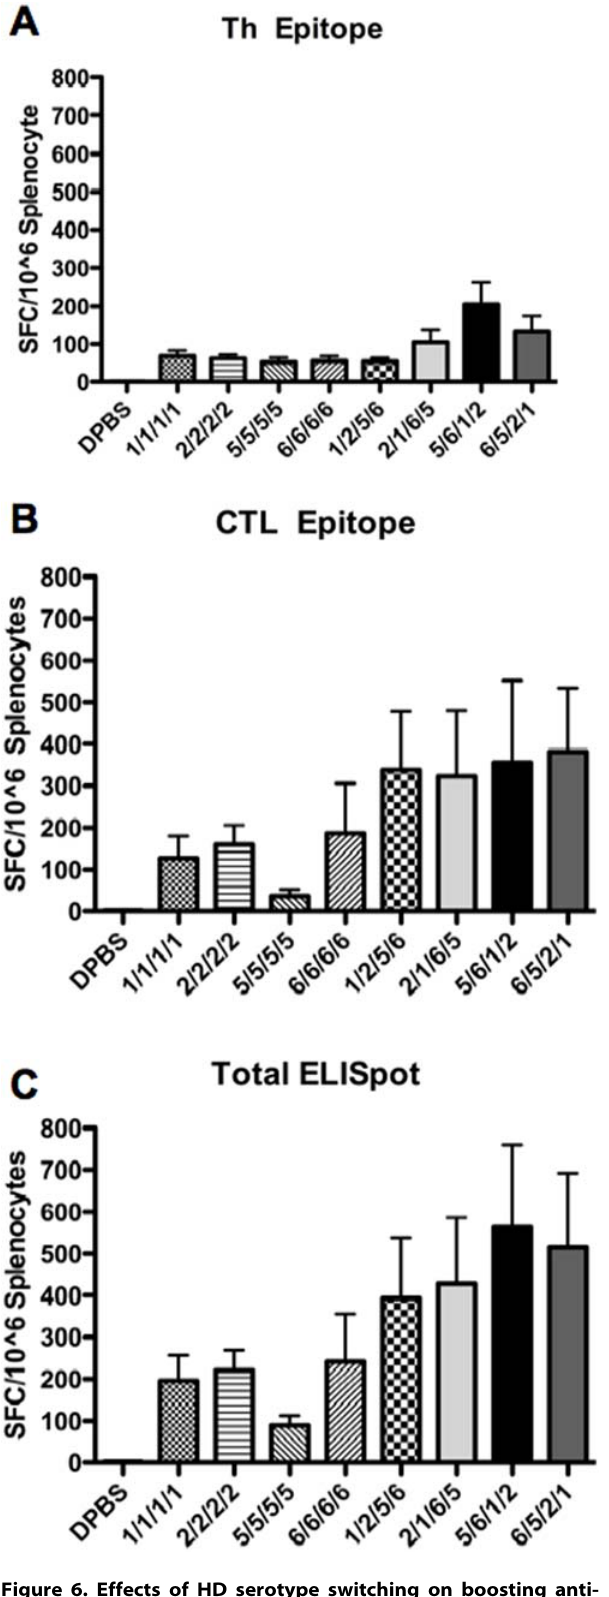
Figure 6. Effects of HD serotype switching on boosting anti- HIV T-helper and CTL responses. Mice were immunized i.m. with HD-Ad expressing HIV-1 gp140 Env. The mice were boosted with homologous or heterologous HD-Ad 3 times before ELISPOT assays were performed. Splenocytes from immunized mice were isolated